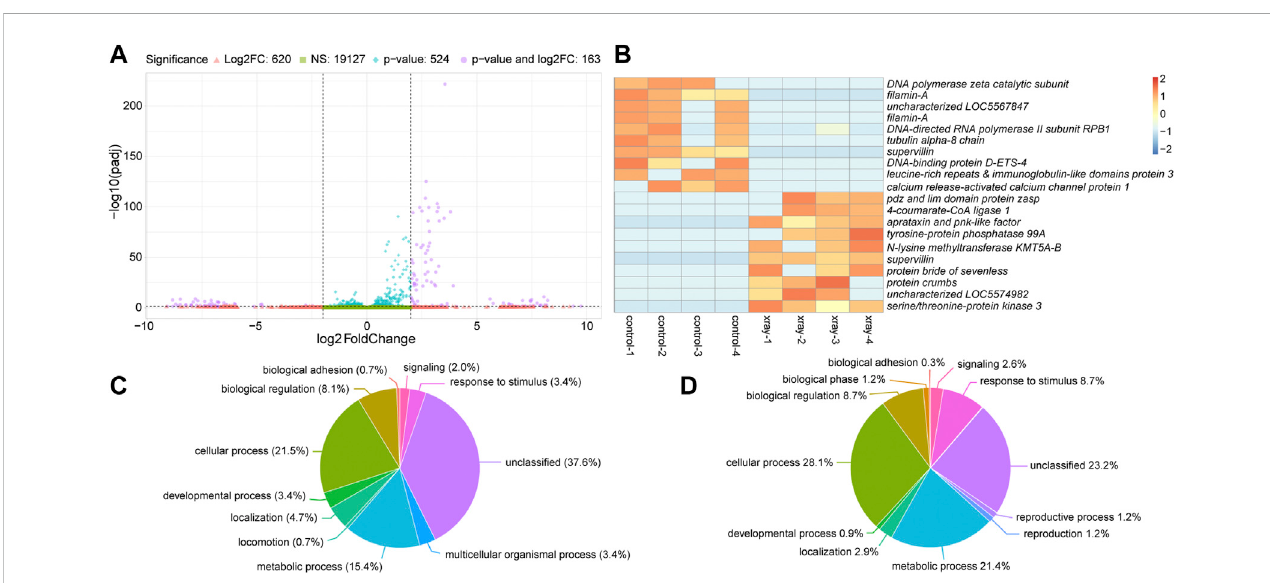
FIGURE 3 Differential gene expression between water-fed non-irradiated (control) and irradiated (x-ray) mosquitoes. (A) . Volcano plot illustrating the differential expressionpatternsbetweentranscriptswithelevatedexpressioninnon-irradiatedmosquitoes(negativevalues)andelevatedexpressioninirradiatedmosquitoes (positive values). See Figure 2 legend for detailed description of volcano plot. (B) . Heatmap showing the ten most signi fi cantly differentially expressed transcripts with atleastfour-fold increase innon-irradiatedorirradiatedmosquitoes.Eachcolumnrepresentsa singlebiological replicate,and each rowrepresentsan individual transcript. (C and D) . Pie charts of gene ontology (GO) analyses of genes upregulated in water-fed non-irradiated mosquitoes relative to irradiated mosquitoes (C) and upregulated in irradiated mosquitoes relative to non-irradiated mosquitoes (D) . See Figure 2 legend for detailed description of these charts.